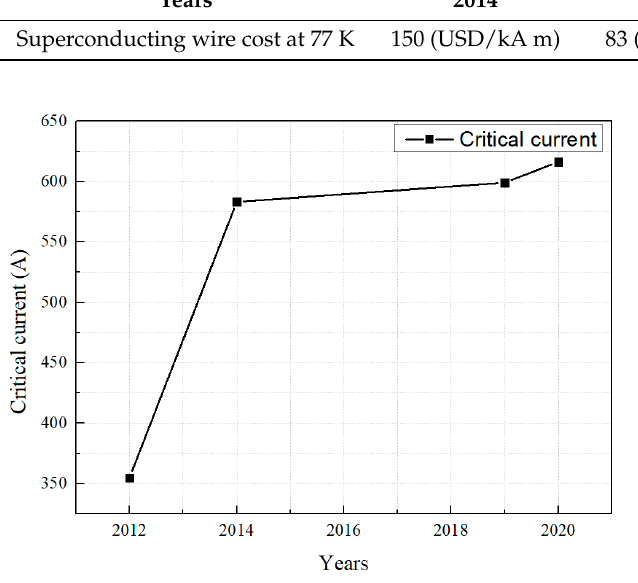
Table 15. The trend of the superconducting wire cost.